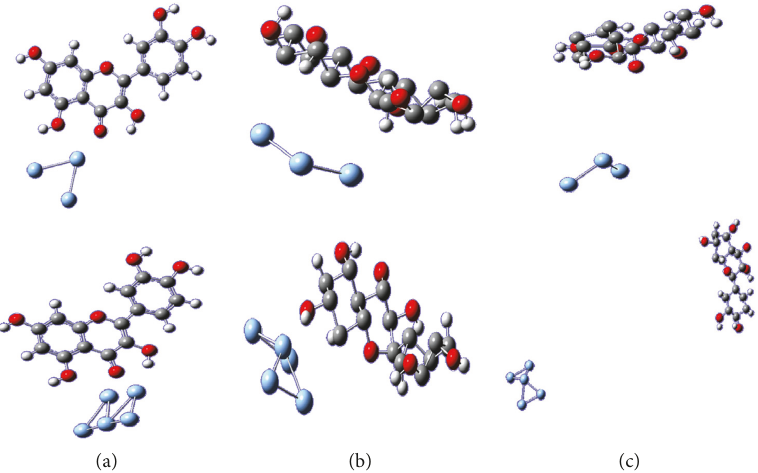
Figure 13: Molecular dynamics performed at 298.15K. Quercetin with 3-and 5-atom silver clusters at (a) 0ps, (b) 5ps, and (c)